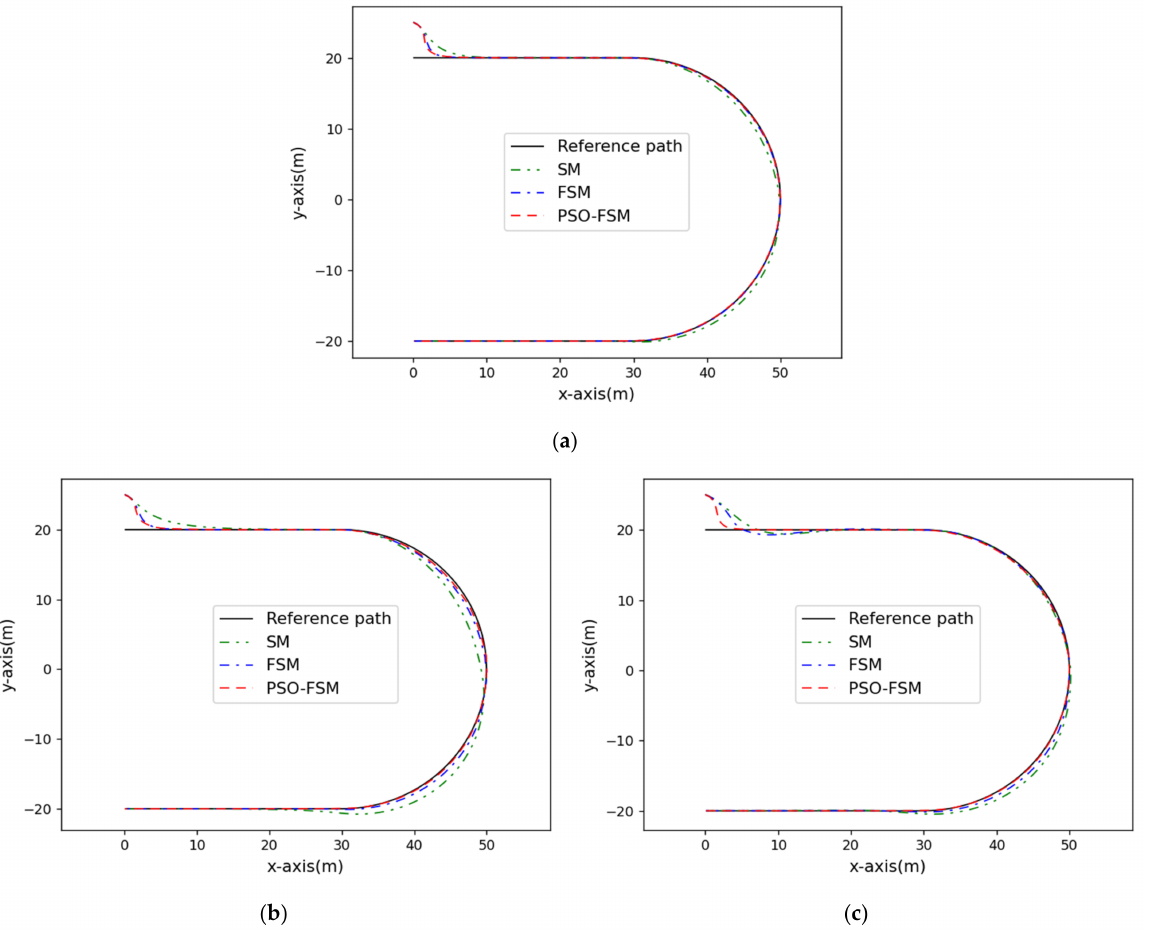
Figure 7. Autonomous turning under different scenarios. ( a ) Autonomous turning under ideal scenario; ( b ) Autonomous turning under high-speed scenario; ( c ) Autonomous turning under steering actuator saturation